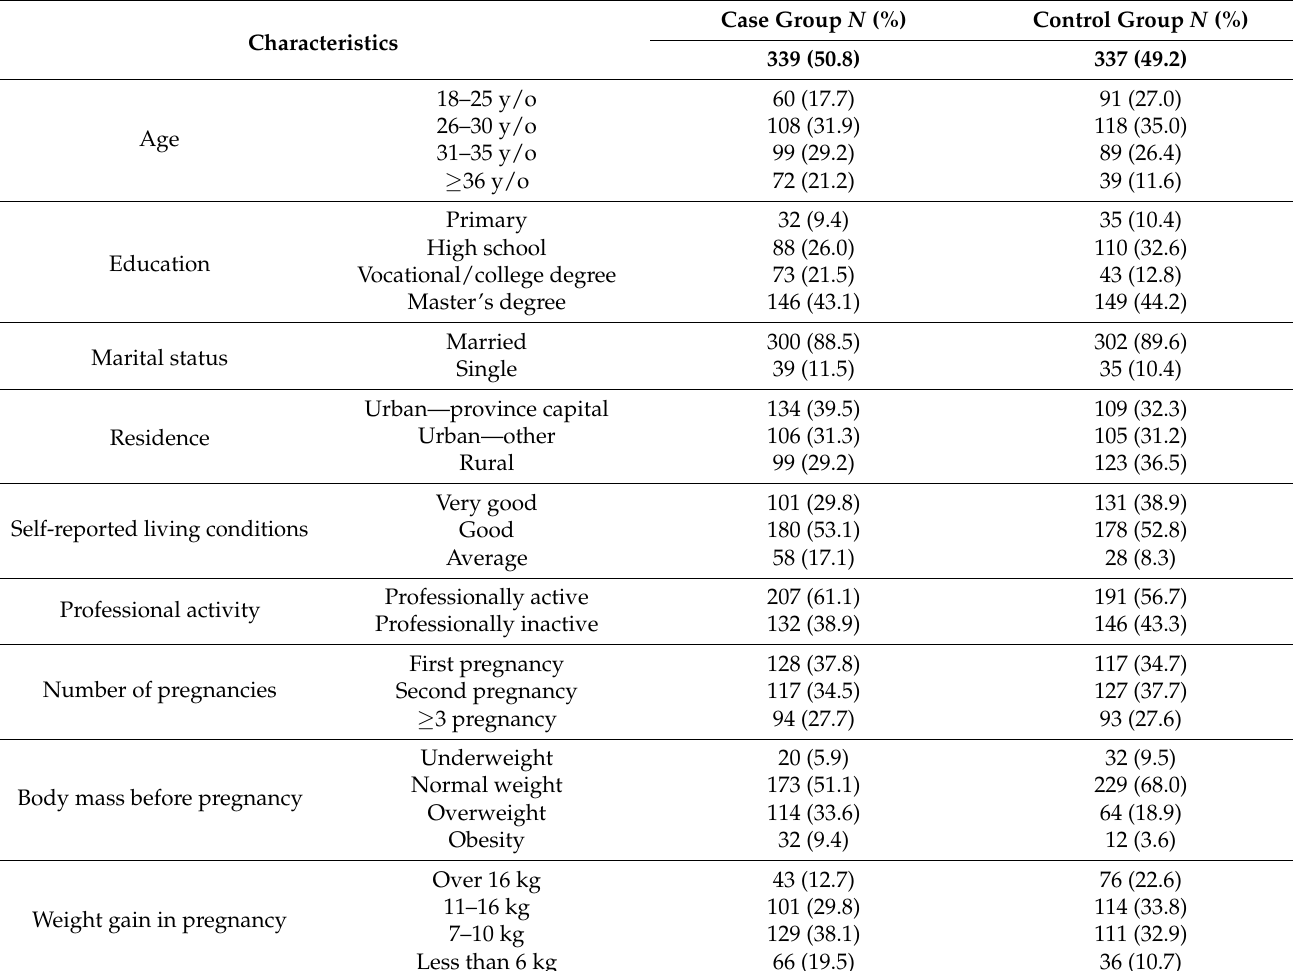
Table 1. Socio-demographic characteristics of the women in the